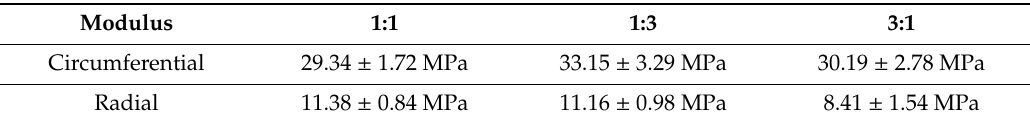
Table 1. Modulus of elasticity of venous valvular tissue under three di ff erent loading ratios (mean ±